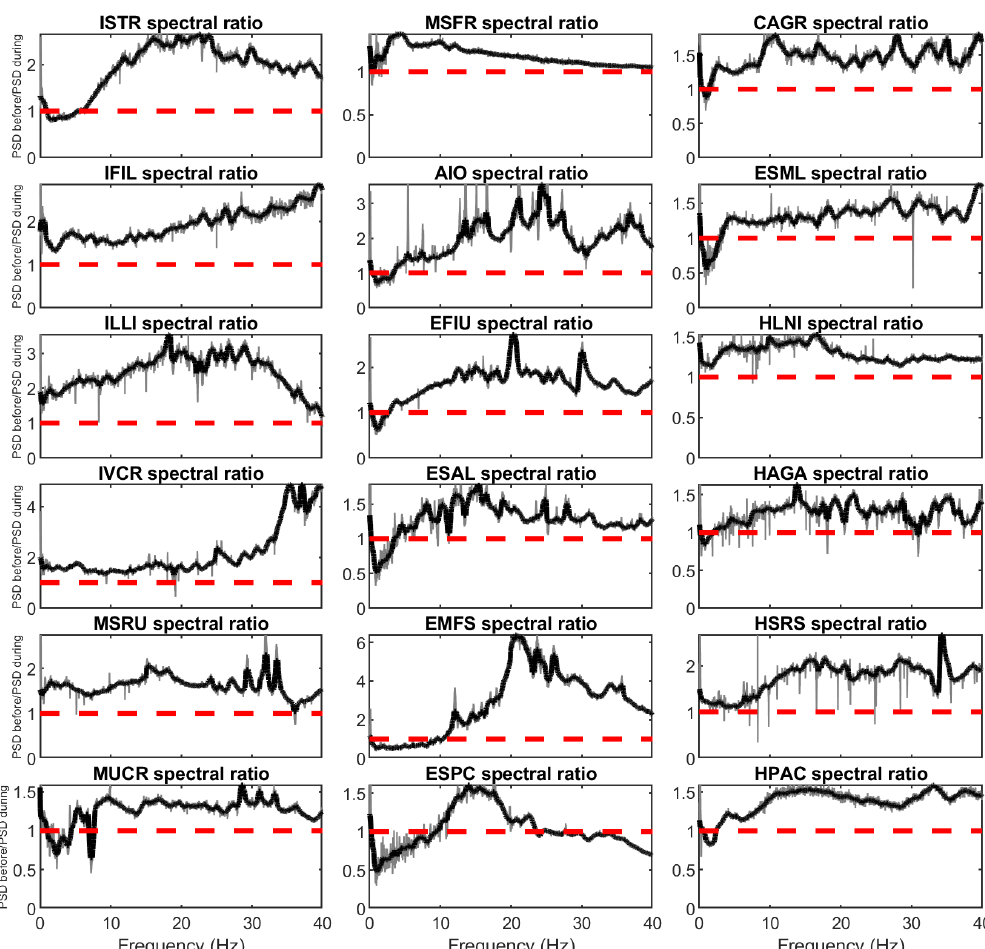
Figure 7. Ratios between the spectra of the vertical component of the seismic signals recorded during two 20d long time windows, extracted before (1–20 February) and during (11 March–1 April) the lockdown (grey lines; see Fig. 6) and corresponding moving median over 0.6Hz (black thick line). The red horizontal dashed lines indicate ratio values equal to 1. The stations are sorted by decreasing latitude from upper left to bottom